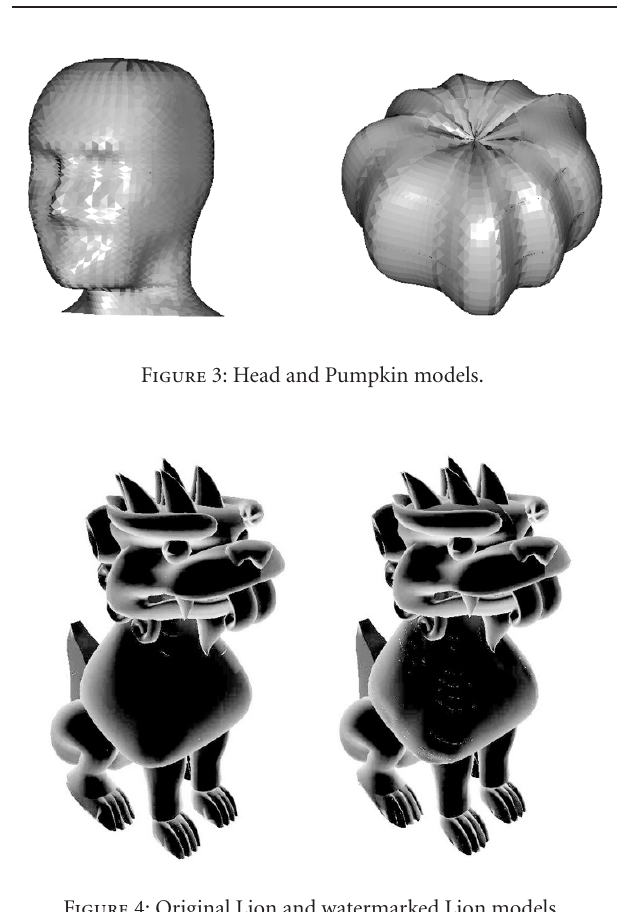
Figure 4: Original Lion and watermarked Lion models.